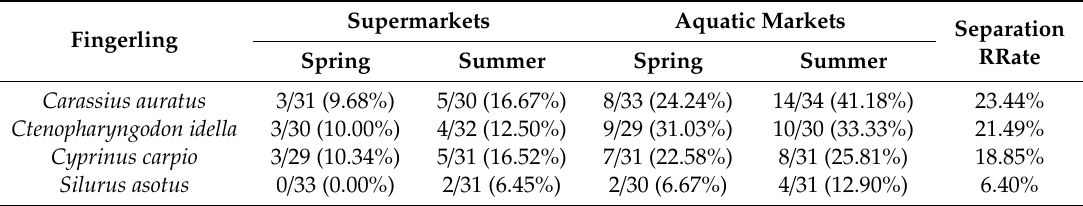
Table 4. Distribution of A. veronii